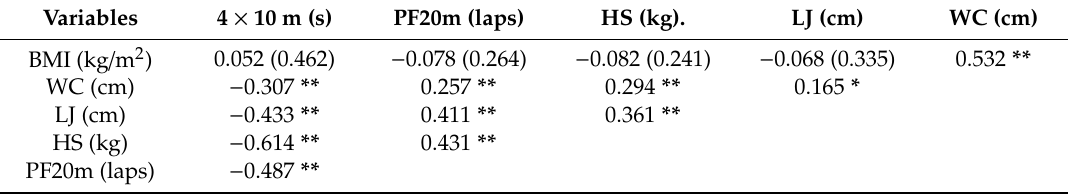
Table 3. Correlations between PREFIT physical fitness ( n =